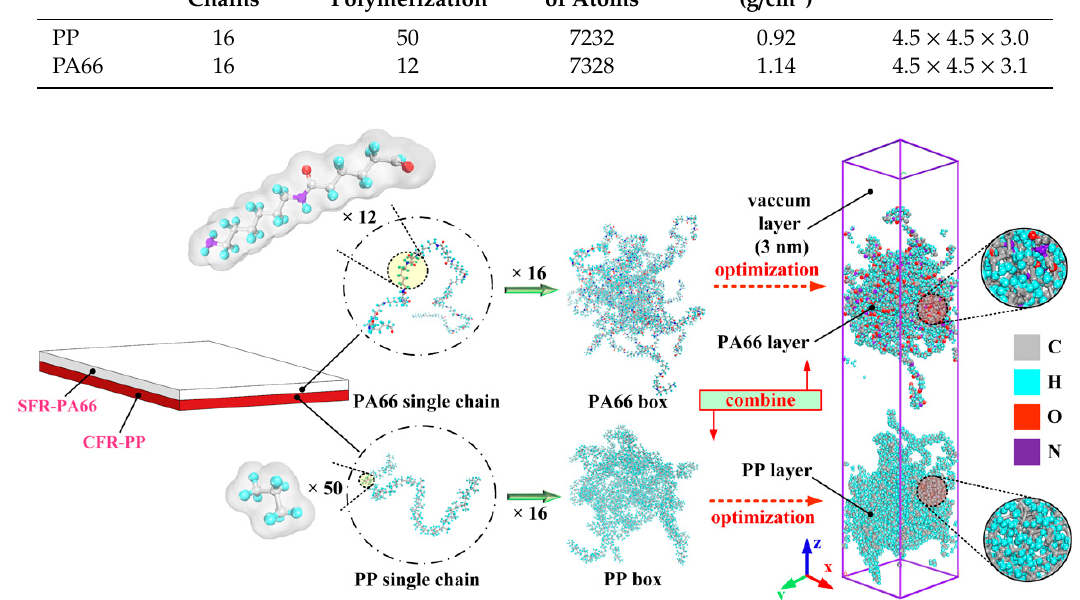
Figure 1. Conformations of all-atom model of hybrid PA66–PP system.